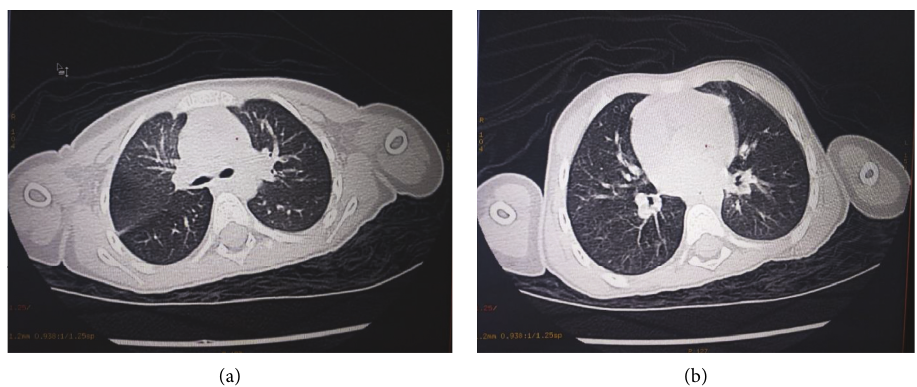
Figure 2: Chest CT scan showing images in favor of pneumopathy COVID-19 CO-RADS